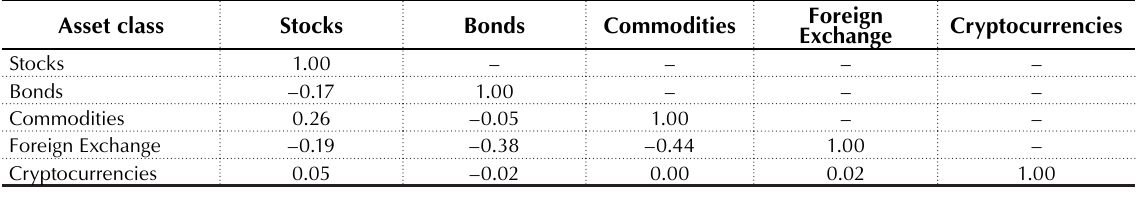
Table 4. Correlation Matrix. Index proxies: S&P500 Index (Stocks), Bloomberg Barclays US Aggregate Bond Index (Bonds), Bloomberg Commodity Index (Commodities), Trade-weighted U.S. Dollar